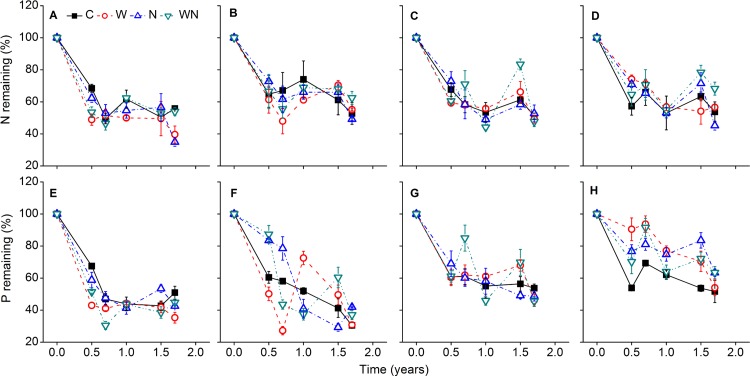
Residual N and P (as percentage of initial content) of fine and coarse roots from E. oxyrrhynchum and S. santolinum during the decomposition process under control (C), water (W), nitrogen (N), and water plus nitrogen addition (WN) treatments (experiment II).(A, E) fine and (B, F) coarse roots of E. oxyrrhynchum; (C, G) fine and (D, H) coarse roots of S. santolinum. Vertical bars represent standard errors (n = 3).